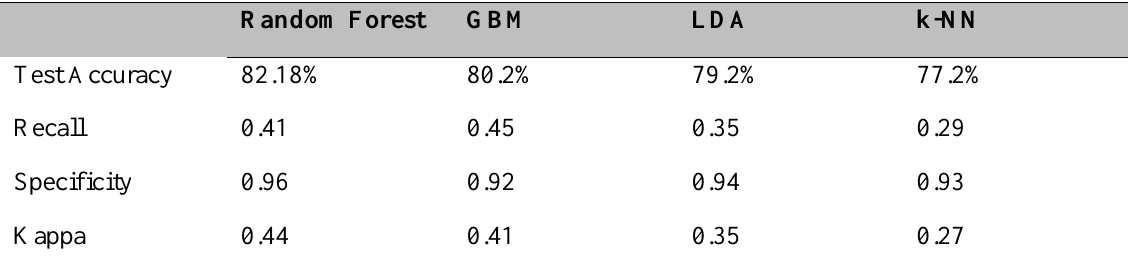
Table 5: Accuracy of Pass/Fail Classification on 10–week data